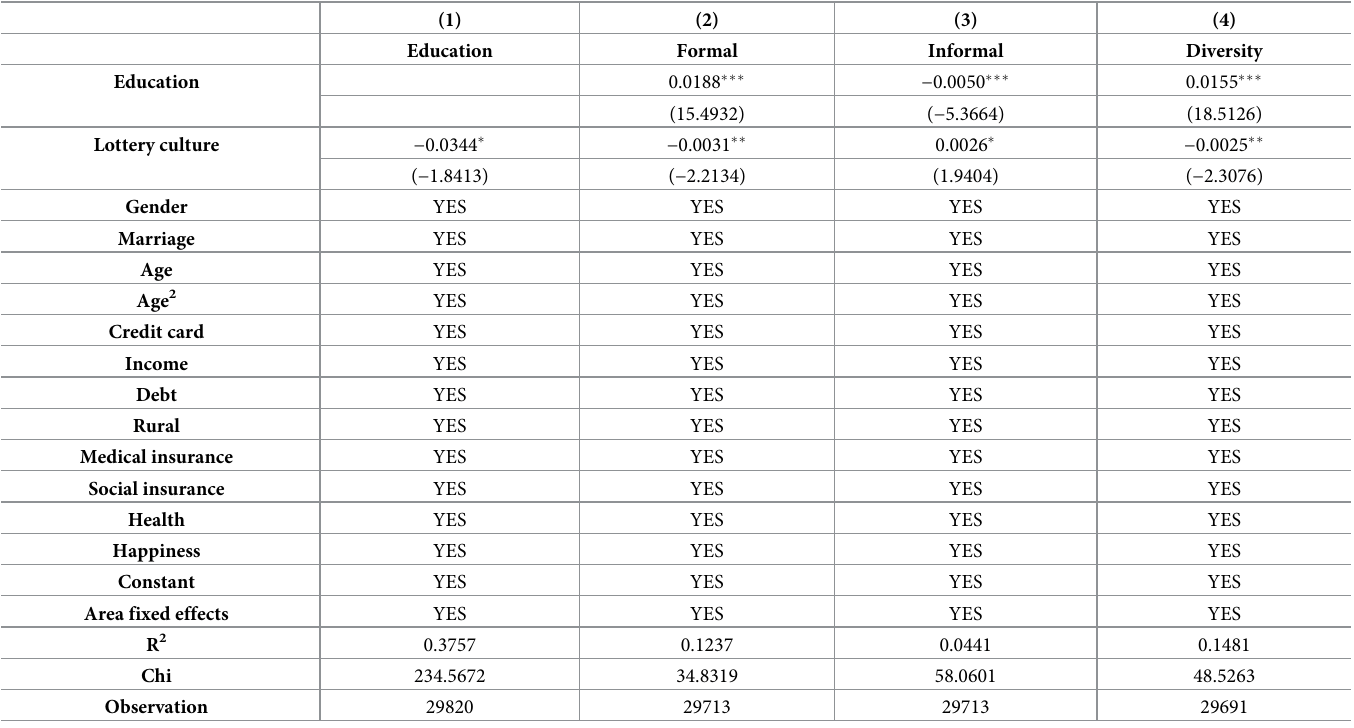
Table 6. “Lottery culture,” human capital, and household financial